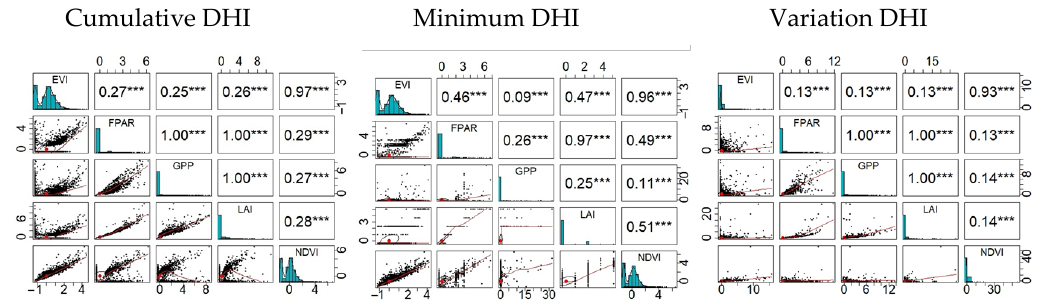
Figure 3. Spearman rank correlations and scatter plots among the three DHIs derived from various MODIS products. Significant relations: *** p < 0.001.